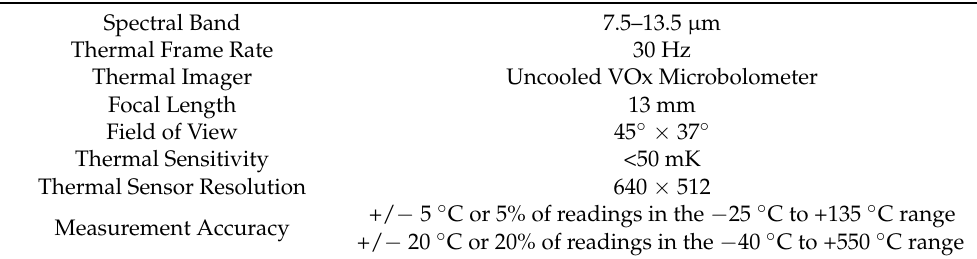
Table 1. FLIR Duo Pro R thermal camera specifications.